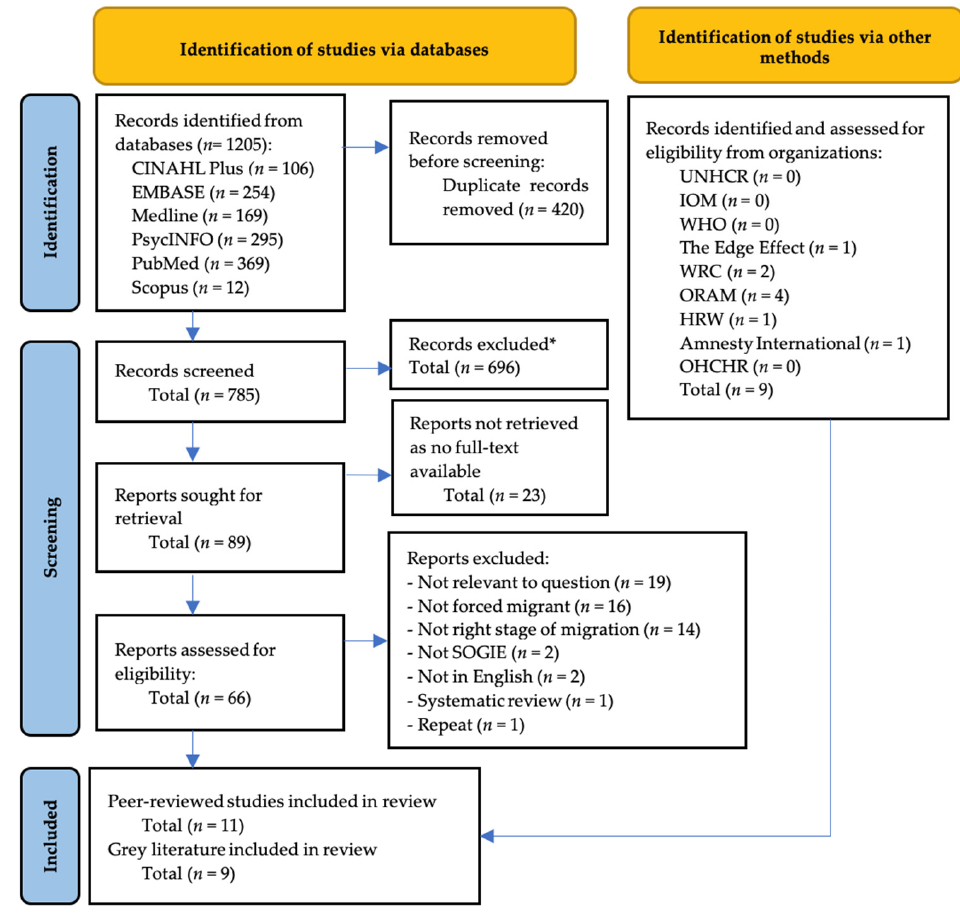
Figure 2. Adapted PRISMA 2020 flow diagram for new systematic reviews, including searches of databases, registers and other sources. N.B. asterisk is used as